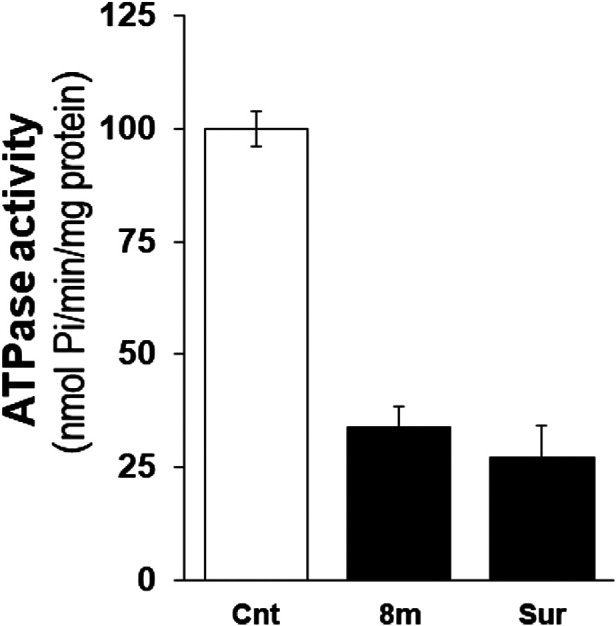
Effect of compound 8m and suramin on ectonucleotidase activity in islets homogenate using 100 µM ATP as substrate. Enzyme activity is expressed in nmol Pi/min/mg of protein. Enzyme activity without any inhibitor was considered 100%. Treatment of homogenate with compound 8m and suramin significantly reduced the enzyme activity. Bars represent means ± SEM for three independent experiments. ***p < 0.0001. Cnt (control), enzyme activity without addition of compound, Sur, enzyme activity by suramin.